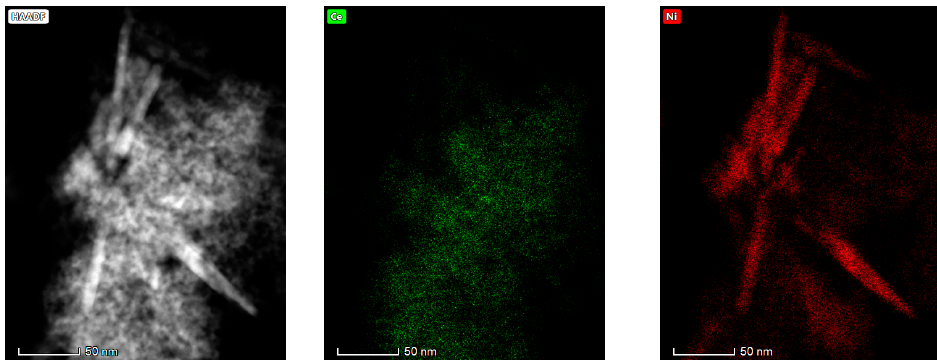
Figure 7. HAADF-STEM images of Ni-Ce-9 and EDS chemical maps of Ni and Ce.